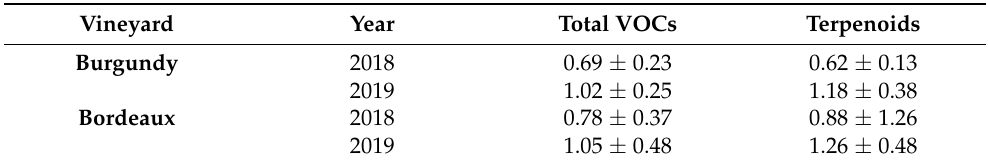
Table 1. Bastid ® induction levels of total VOCs and terpenoids. Experiments were performed in Burgundy (cv. Chardonnay) and Bordeaux (cv. Cabernet franc) vineyards in 2018 and 2019. VOCs were collected using the BAG mode. Fold changes (FCs) correspond to the averaged of Bastid ® over H 2 O (control) treatments ratio